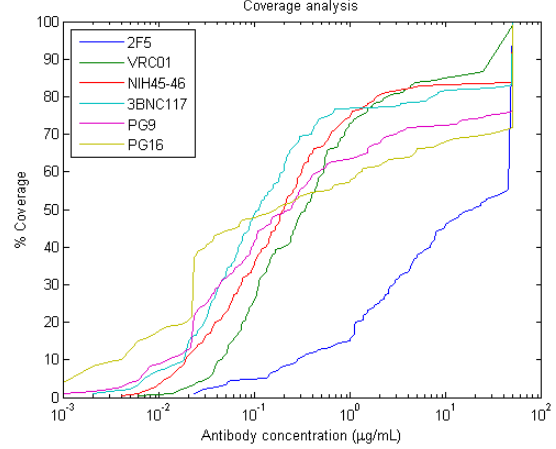
Figure 8. Coverage curves for given antibodies.